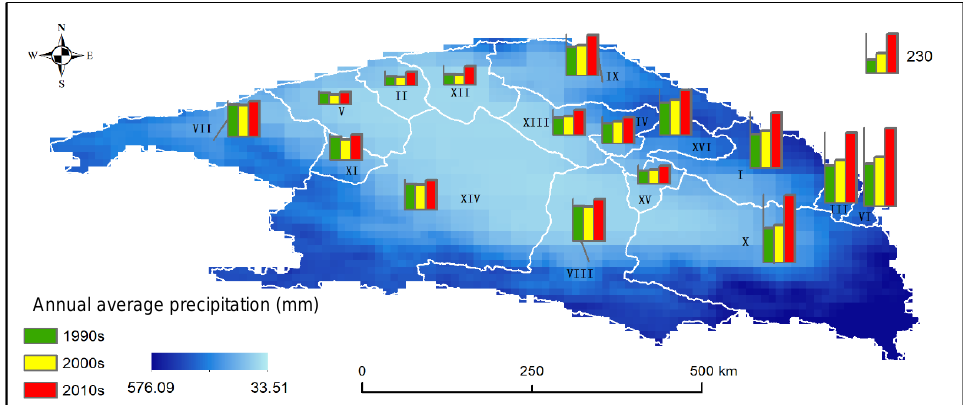
Figure 7. Spatial pattern of precipitation in the Qaidam Basin from 1990 to 2020. Green, yellow, and red histograms represent the annual average precipitation for different decades in each WRZ, with a scalar in the upper right corner.